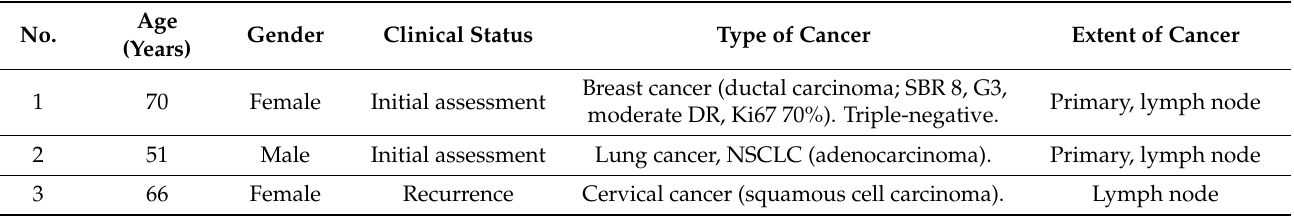
Table 3. Patient characteristics before [ 99m Tc]Tc-iFAP and [ 18 F]FDG imaging. Oncological diagnoses were confirmed via histopathological